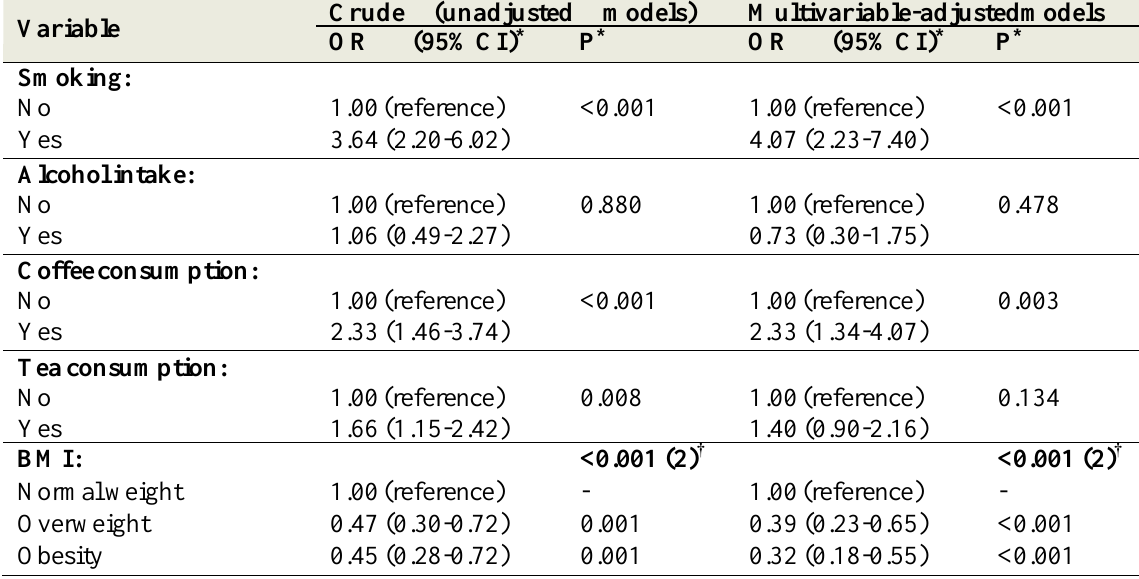
table, multivariable-adjusted models were additionally controlled for age, marital status, employment status and